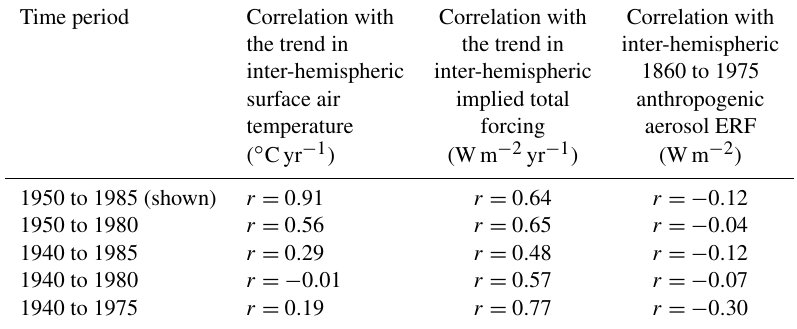
Table 2. Table of Spearman’s rank correlation coefficients for the 1950 to 1985 trend in global mean 5-year rolling mean (cid:56) ITCZ and additional global inter-hemispheric (60 ◦ S to 60 ◦ N) variables. Variable Correlation with Trend in inter-hemispheric total AOD (yr − 1 ) r = − 0 . 23 Trend in inter-hemispheric dust AOD (yr − 1 ) r = − 0 .